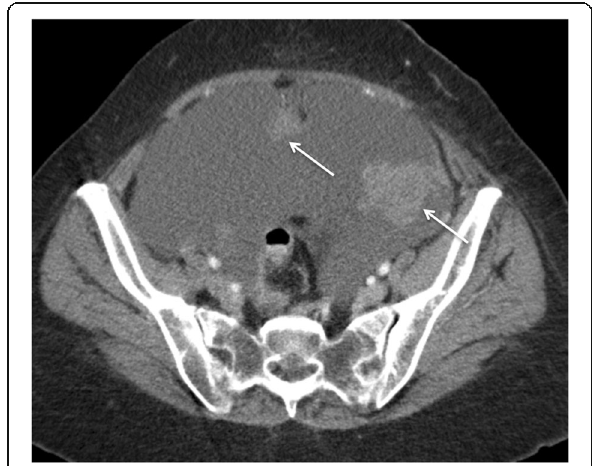
Fig. 1 Axial CT post-contrast image of the pelvis showing a nodular enhancing peritoneal metastasis pattern in a BRCA-1 mutant